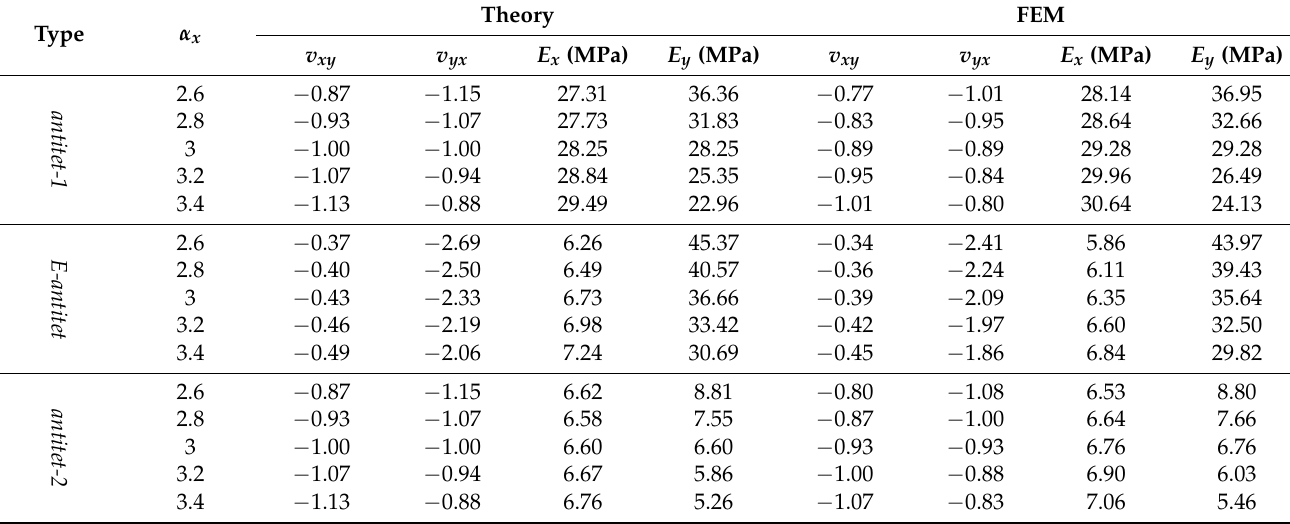
Table A3. Detailed results of Poisson’s ratio and Young’s modulus of E-antitet at different α x